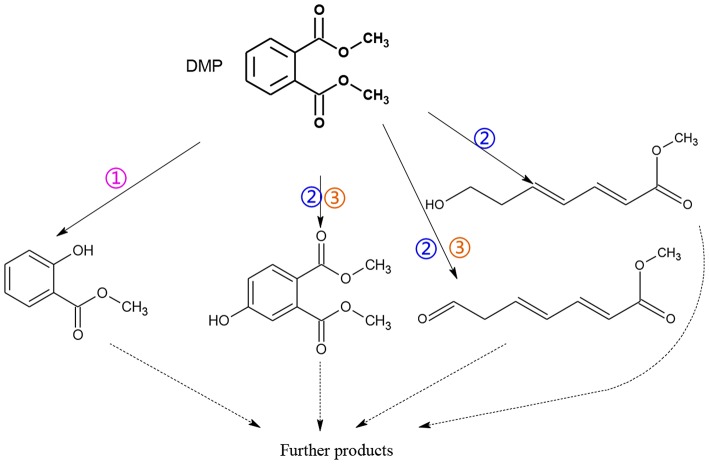
Proposed pathway for DMP degradation in different systems (① UV system; ② UV/TiO2 system; ③ UV-Vis/Bi2WO6 system).